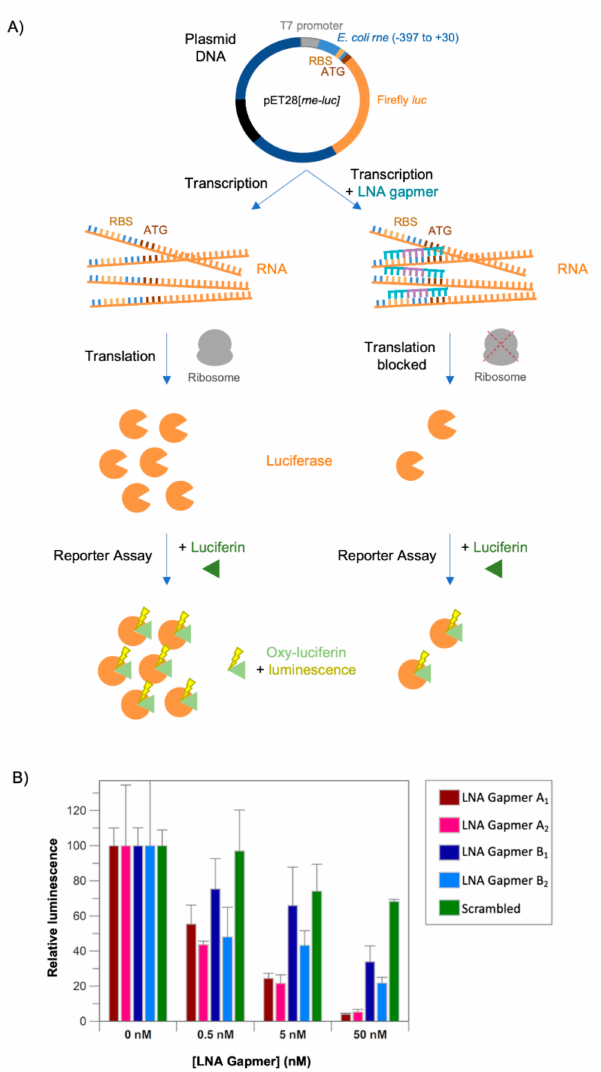
Figure 3. An in vitro cell-free transcription-translation system, coupled with a luciferase assay. ( A ) A schematic of the assay steps. A translational fusion of the − 397 to +30 region of E. coli rne and the coding region of the firefly luciferase ( luc ) gene (Supplementary Figure S3) was cloned into pET28b to generate pET28[ rne-luc ]. (Left) An in vitro cell-free transcription-translation system transcribes the rne-luc gene into RNA (orange; RBS, gold; start codon, brown) and the RNA is translated to produce luciferase (orange wedge). Luciferase converts luciferin (dark green triangle) into oxy-luciferin (light green triangle) and emits light (yellow lightning bolt). (Right) In the presence of LNA gapmer (teal/mauve), translation is inhibited, less luciferase is produced, less luciferin is converted to oxy- luciferin and less light is emitted. ( B ) A chart showing the relative luminescence in the presence of 0 nM, 0.5 nM, 5 nM or 50 nM LNA gapmer A 1 , A 2 , B 1 , B 2 or Scrambled LNA gapmer. Data have been normalised to the total luminescence observed in the absence of LNA gapmer. Data are the average of three experimental repeats and error bars represent the